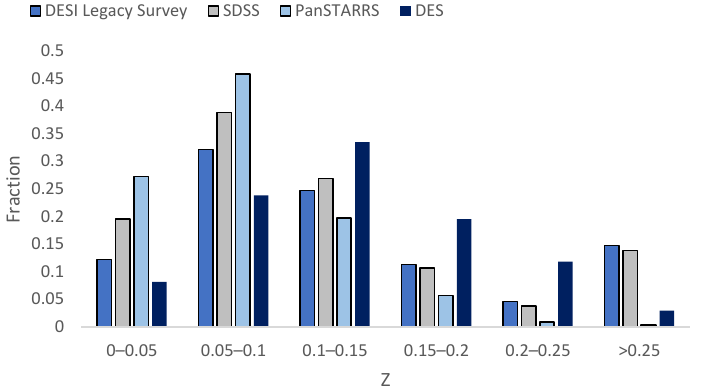
Figure 3. The distribution of the DES, DESI Legacy Survey, SDSS, and Pan-STARRS galaxies in different redshift ranges. With the exception of SDSS, the distribution was determined by a subset of objects with